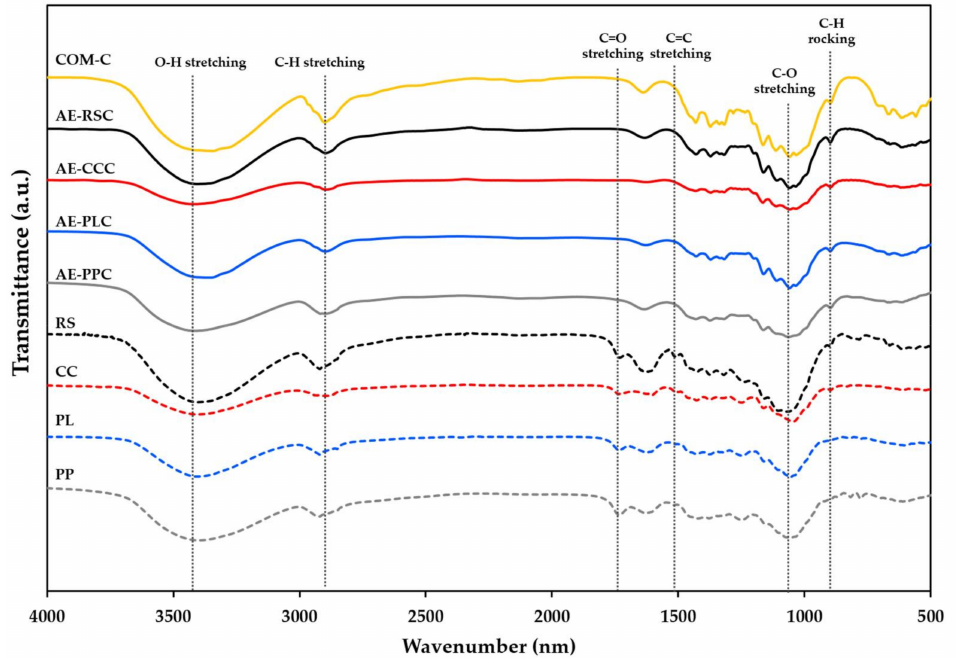
Figure 2. FTIR spectra of cellulose samples without and with alkaline processing of agricultural waste materials and their comparison with the commercial cellulose. RS: rice straw; CC: corncob; PL: pineapple leaf; PP: pineapple peel; AE-RSC: Alkaline extraction of rice straw cellulose; AE-CCC: Alkaline extraction of corncob cellulose; AE-PLC: Alkaline extraction of pineapple leaf cellulose; AE-PPC: Alkaline extraction of pineapple peels cellulose; and COM-C: Commercial